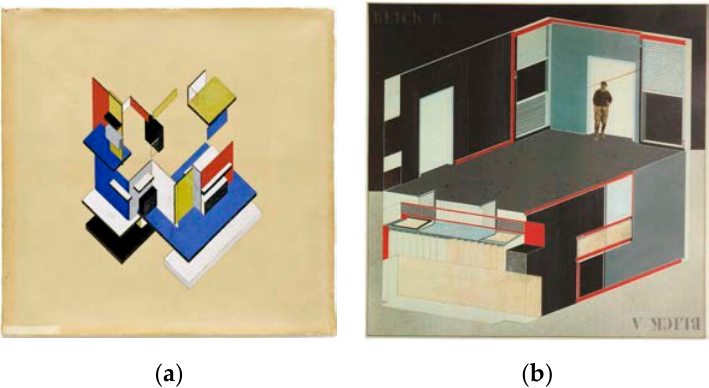
Figure 8. ( a ) Theo van Doesburg and Cornelis van Eesteren, Contra-Construction Project, 1923; ( b ) El Lissitzky, Cabinet of Abstraction,